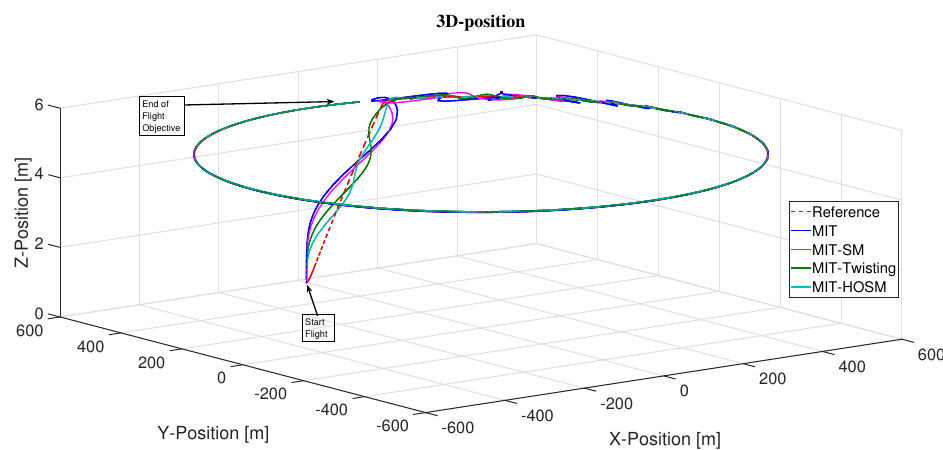
Figure 7. 3D Trajectory following